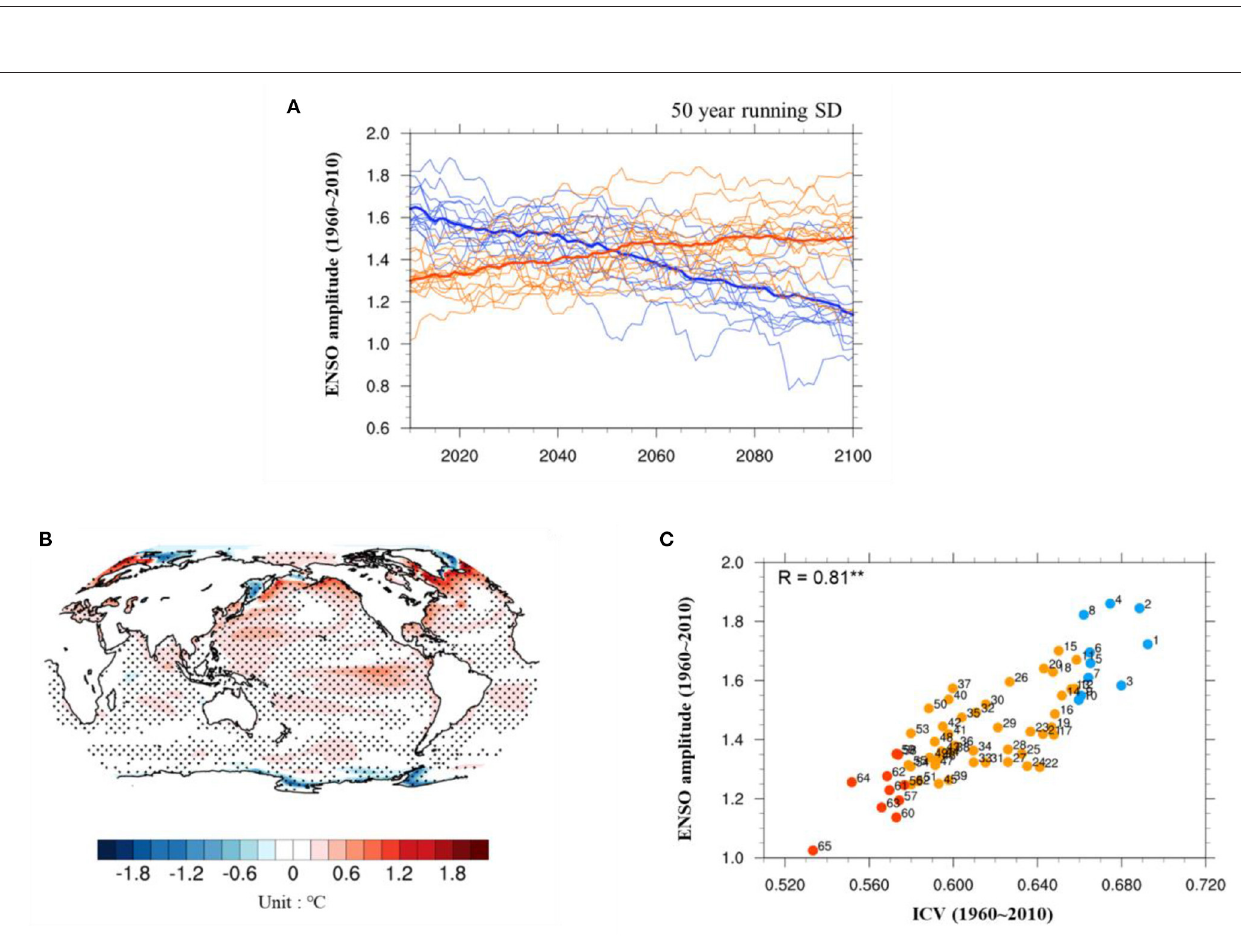
Frontiers in Climate |